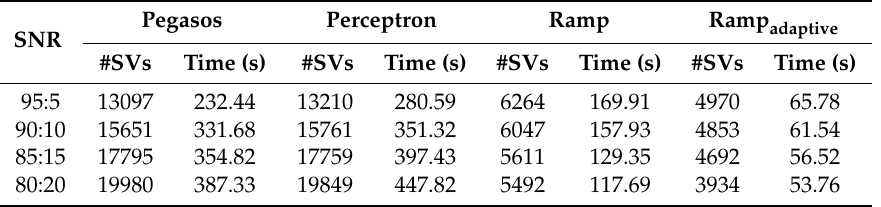
Table 1. The #Support Vectors (SVs) and running time of kernel based online learning algorithms. Pegasos Perceptron SNR